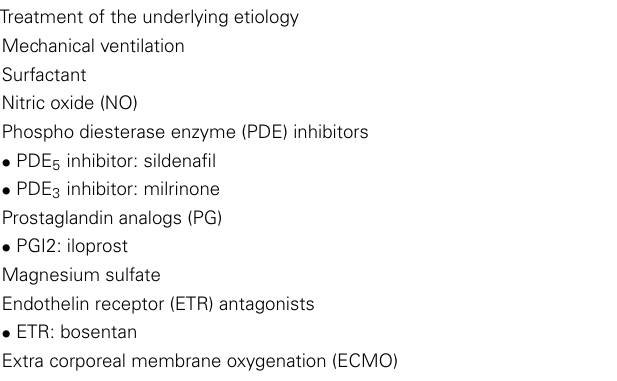
Table 2 |Treatment of